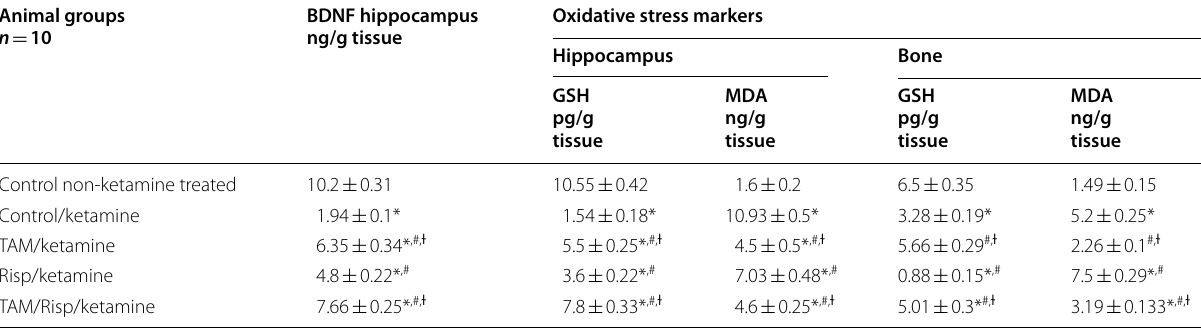
Table 2 Effect of test drugs on BDNF in hippocampus and oxidative stress markers in hippocampus and femur bone, of ketamine treated